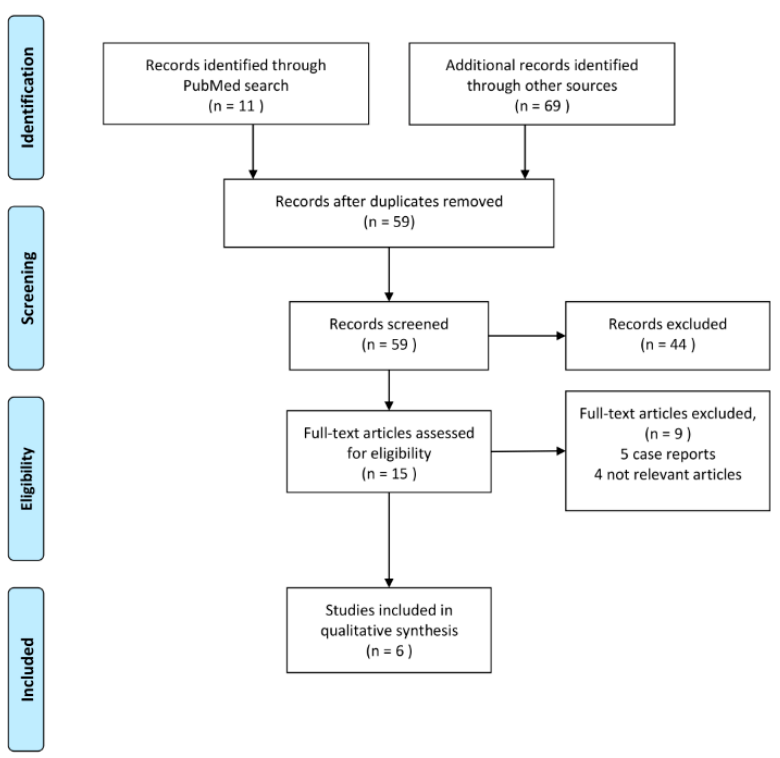
Figure 3. Overview of the literature search strategy and selection of relevant studies.